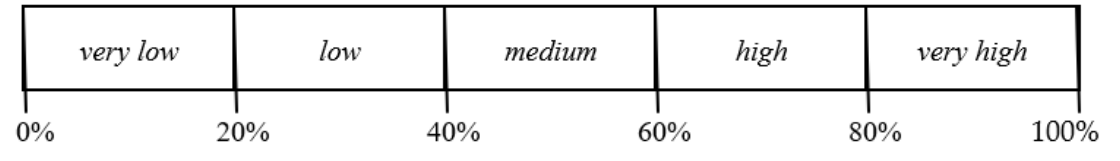
Figure 1. Verbal scale for chances of survival.